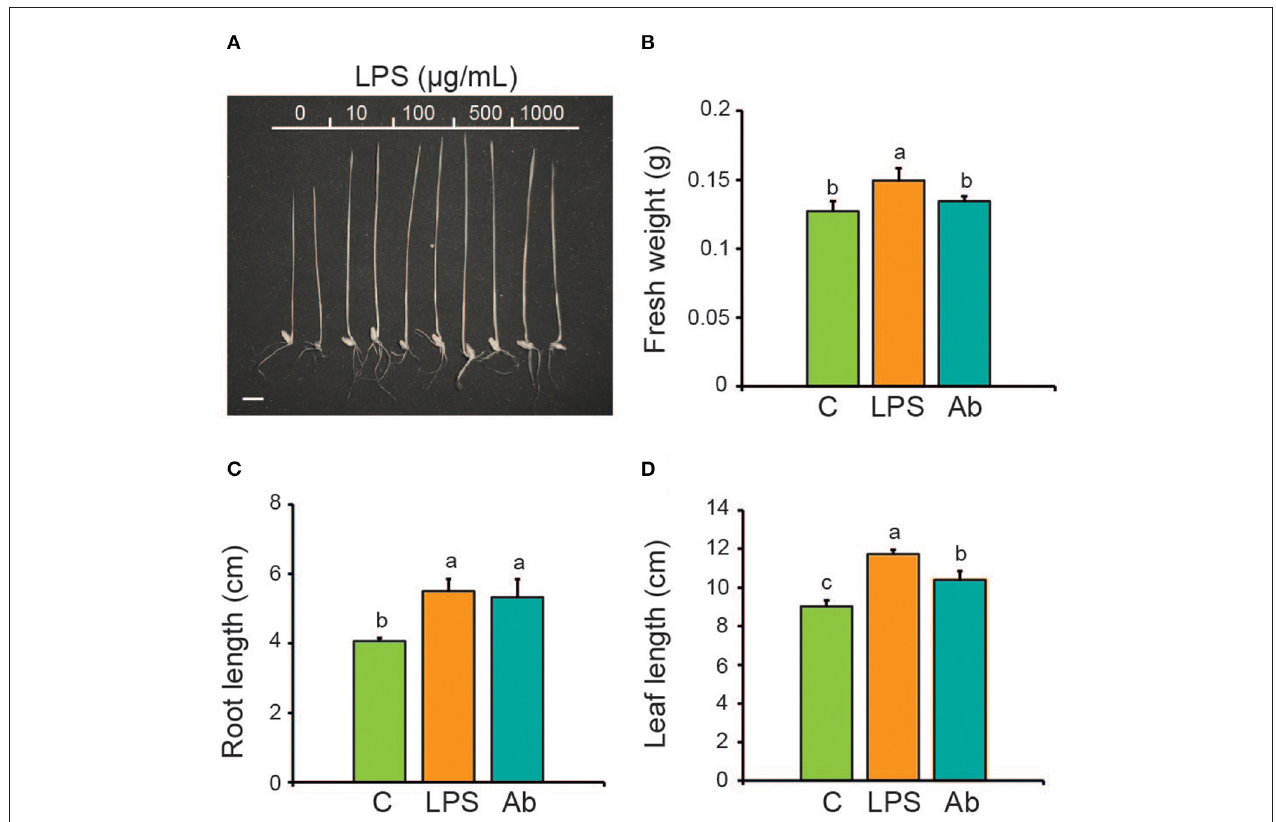
FIGURE 1 | Effect of A. brasilense LPS on wheat seedlings growth. LPS were added to seedlings growing in liquid MS medium and after 4 days growth parameters were analyzed and compared with the inoculation of A. brasilense cells. (A) Image of wheat seedlings treated with increasing LPS concentrations. Barr = 1cm. (B) Total fresh weight. (C) Root length. (D) Leaf length. C, Control (untreated seedlings); LPS, Lipopolysaccharides; Ab, Azospirillum brasilense . LPS in panels (B–D) were used at 100 µ g/mL. A. brasilense was inoculated at 10 6 CFU/mL. Data are mean ± SE of three independent experiments ( n = 10). Letters above bars indicate significant differences according to a Duncan test ( p <